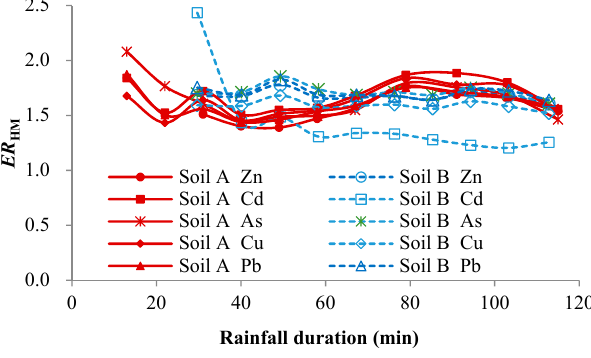
Figure 7. Enrichment ratios of heavy metals and metalloids ( ER HM values) of eroded particulate matter during the simulated-rainfall experiment.